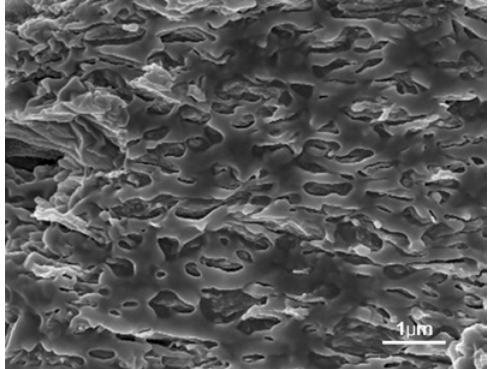
Figure 6: SEM image of fracture surface of rGO@PDOPA/PVDF hybrid film containing 1.32 vol% rGO